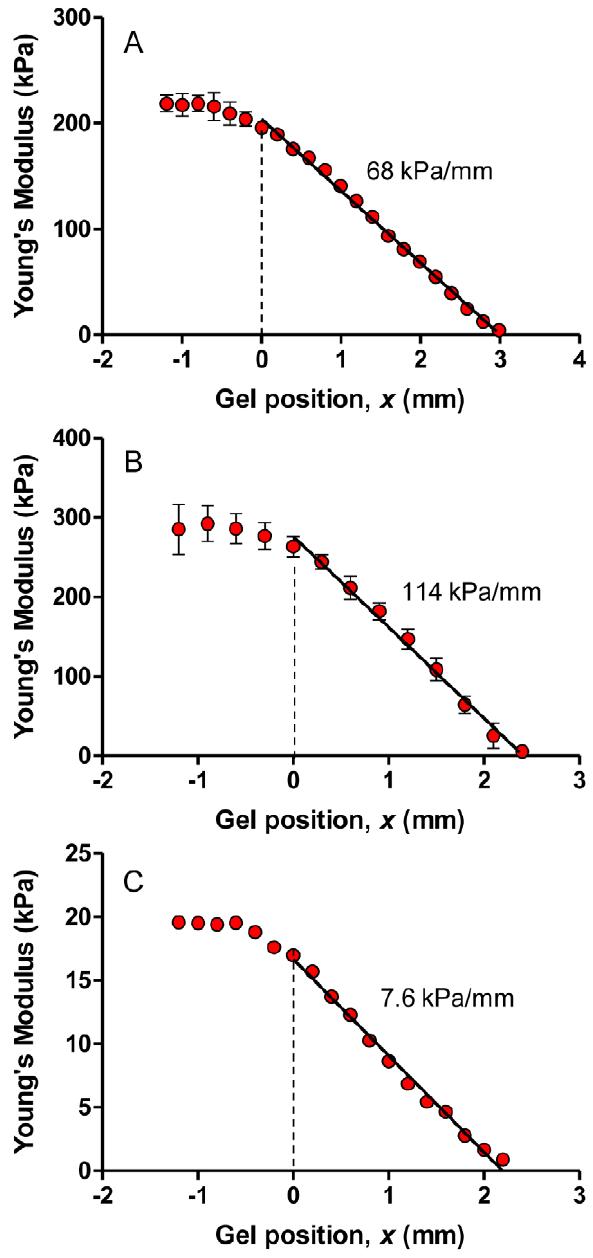
Figure 3. Profile of the elasticity of hydrogels produced by linearizing the stiffness gradient as explained in Text S1, Fig. S2 and Fig. S3. (A) A solution of 15% acrylamide and 1% bis- acrylamide produces a stiffness gradient hydrogel of , 68 kPa/mm when irradiated for 240 s with the speed protocol optimized to linearize the stiffness profile (error bars: SD of 3 replicates). (B) The same acrylamide/bis-acrylamide solution produces a stiffness gradient hydrogel of , 114 kPa/mm when illuminated for 270 s with a similar variable speed protocol (error bars: SD of 6 replicates). (C) A shallower stiffness gradients of , 7.5 kPa/mm can be obtained by using a solution of 8% acrylamide and 0.48% bis-acrylamide and irradiating for 240 s with a variable speed protocol (Mean of 2 replicates). Note that panels A–C share an almost identical scale in the x -axis but different scales in the y -axis.